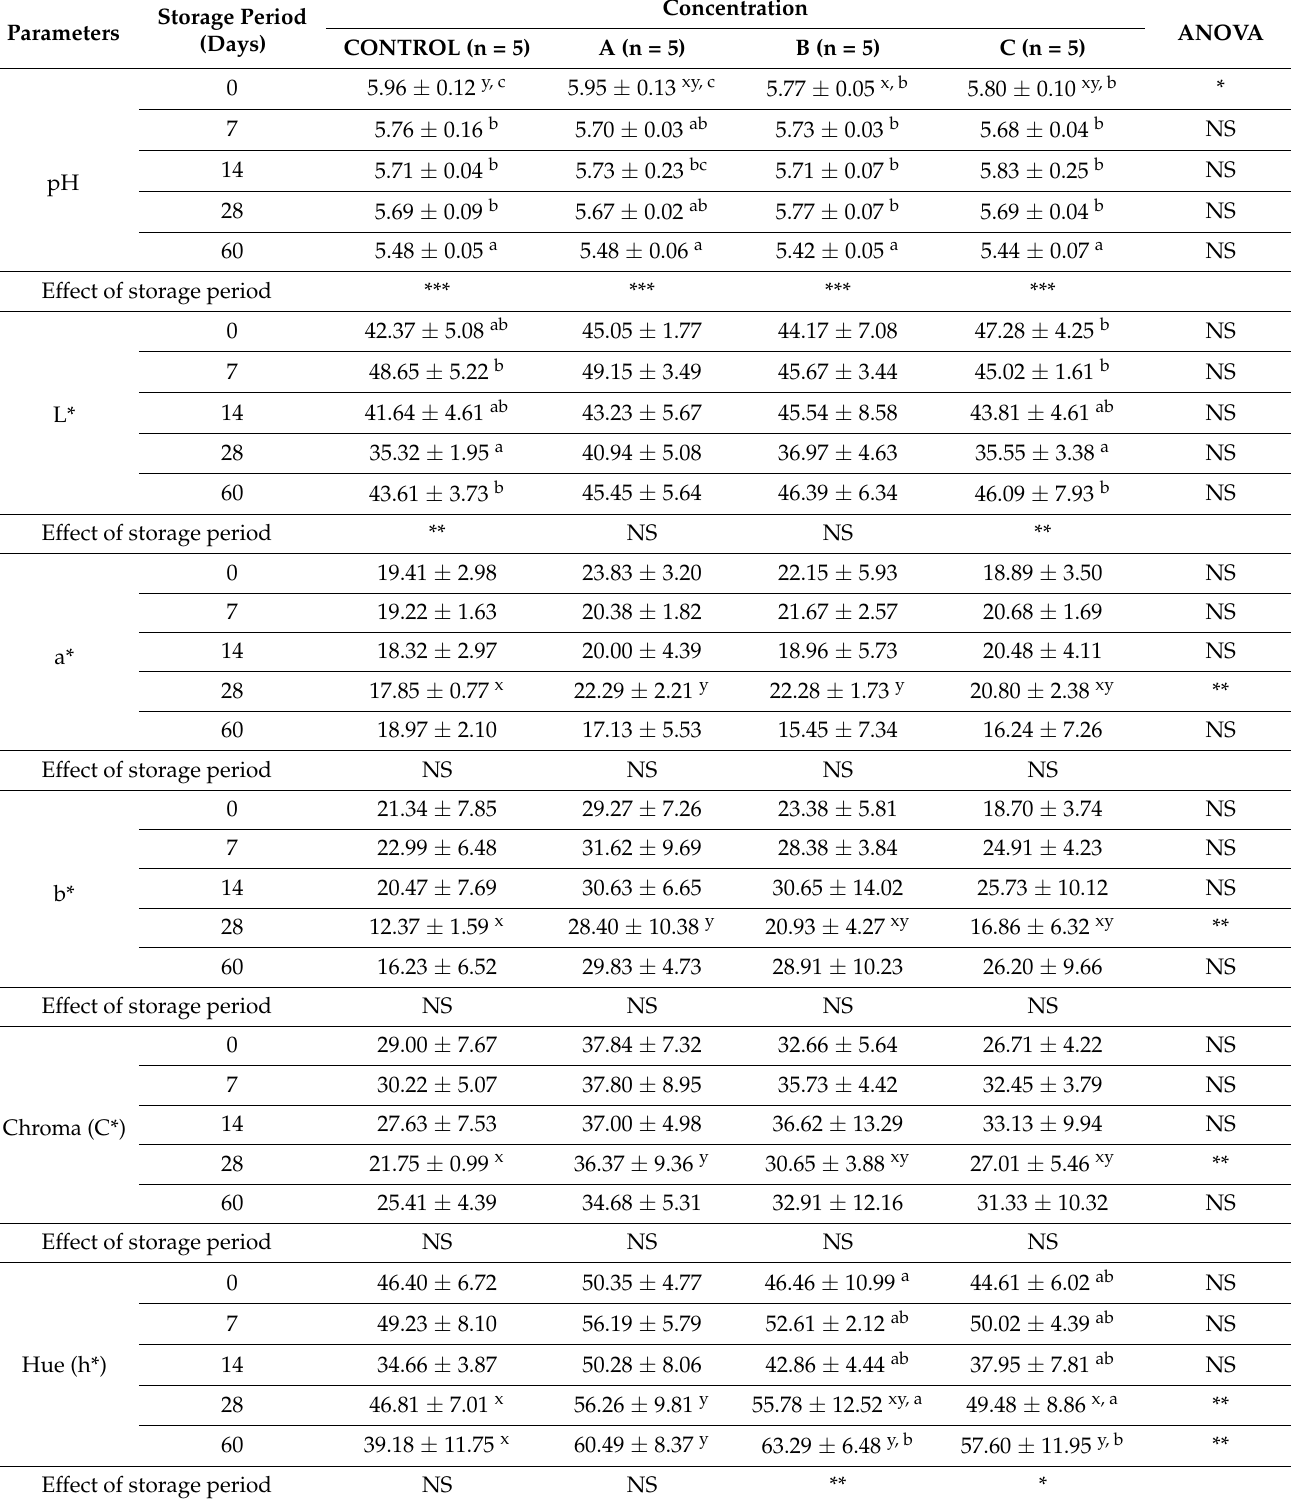
Table 1. Effect of different added concentrations of saffron and storage period on the physicochemical characteristics (pH and color; mean ± s.e.) of sachets of ham slices of